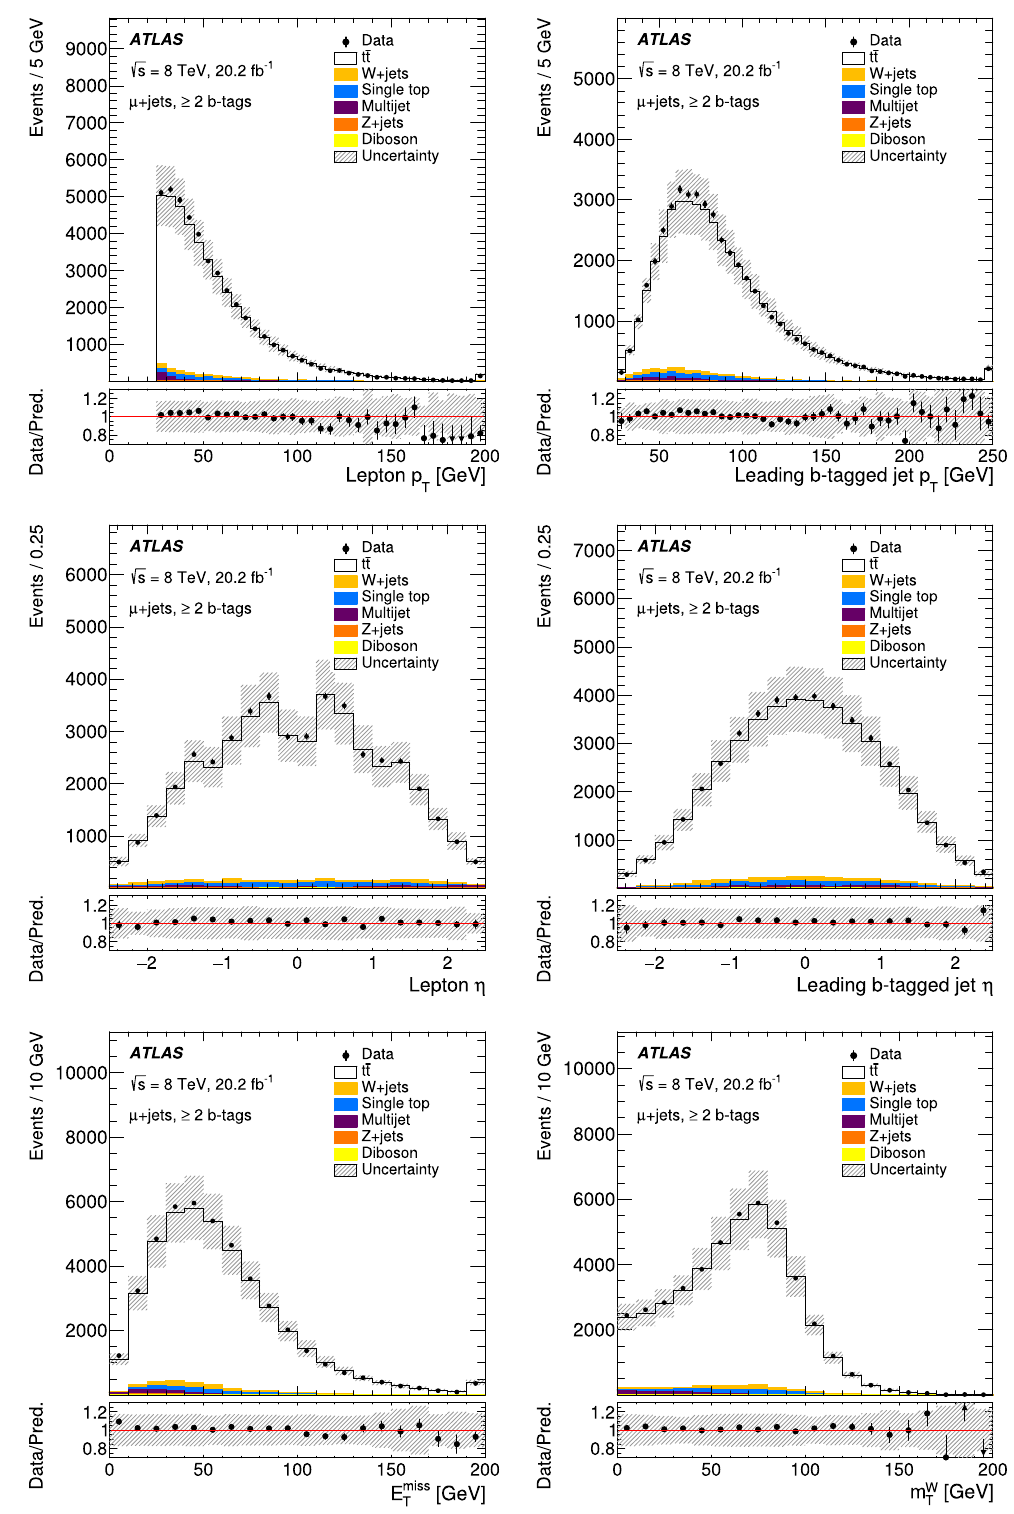
Fig. 2 Distributions of the lepton and leading b -tagged jet p T , lepton bands show the normalisation uncertainty in the signal and background and leading b -tagged jet η , E miss contributions and the signal model systematic uncertainties. The first and m W in the muon+jets channel for T T events with at least two b -tagged jets after event selection. The hatched and last bins contain underflow and overflow events,